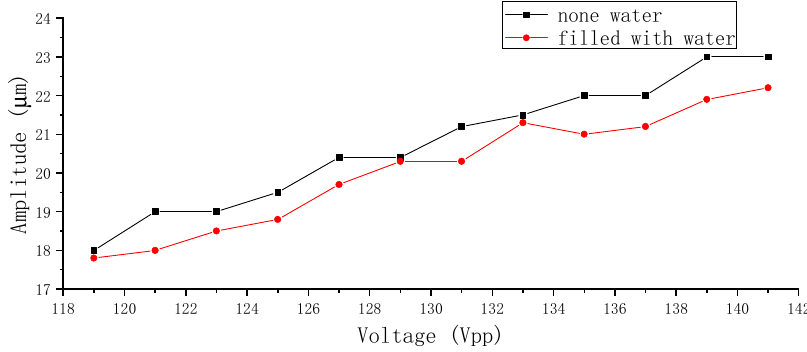
Figure 7. The amplitude of the PZT vibrator under two operating conditions.